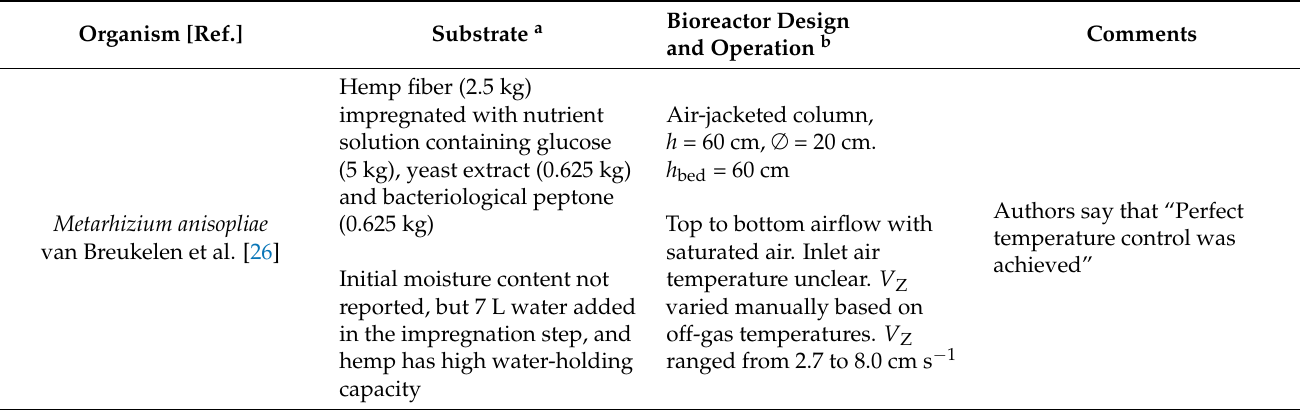
Table 3. Use of packed-bed bioreactors with high porosity substrates or with bed porosity modifiers. Organism